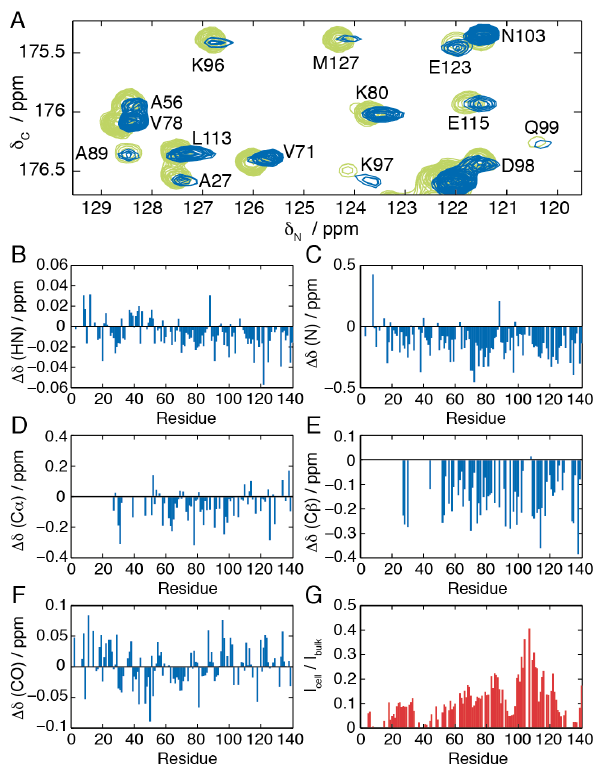
Figure 2. Analysis of backbone chemical shift changes and line broadening. (A) Overlay of 13 C/ 15 N slices through the HNCO spectrum of a Syn in bulk solution (green) and the deconvolved spectrum of a Syn expressed within cells (blue), showing resonances with 1 H chemical shifts between 8.45 and 8.55 ppm. (B–F) Backbone chemical shift changes observed for intracellular a Syn relative to the protein in bulk solution. (G) Relative HNCO intensities of intracellular a Syn compared to a Syn in bulk aqueous solution.